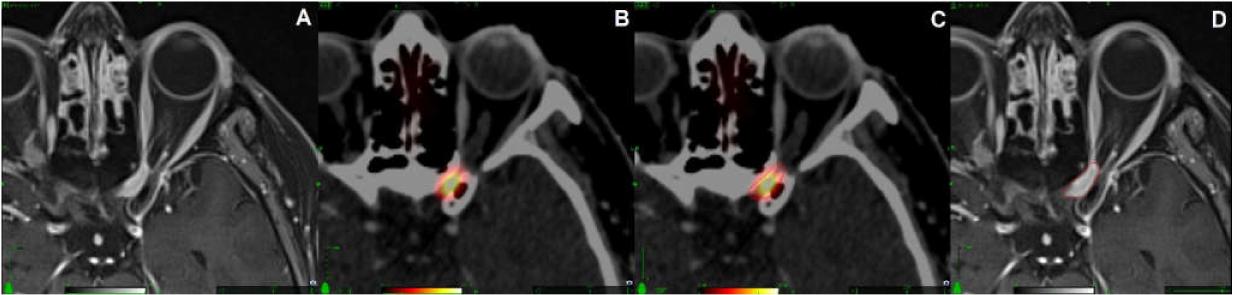
Figure 1. Radiosurgery contouring process: ( A ) Optic nerve sheath meningioma (ONSM) left eye difficult to see on MRI alone; ( B ) 68Ga-DOTATOC-PET/MRI co-registered with the planning CT demonstrates left canalicular location of ONSM; ( C ) initial tumor contouring based on the PET signal; ( D ) fine-tuning of the tumor volume using the MRI of the hybrid PET/MRI, no safety margin was added to generate the planning target volume (red line). MRI, magnetic resonance imaging, Ga68-DOTATOC, gallium-68-labeled (DOTA0-Phe1-Tyr3) octreotide; PET, positron emission tomography; CT, computer